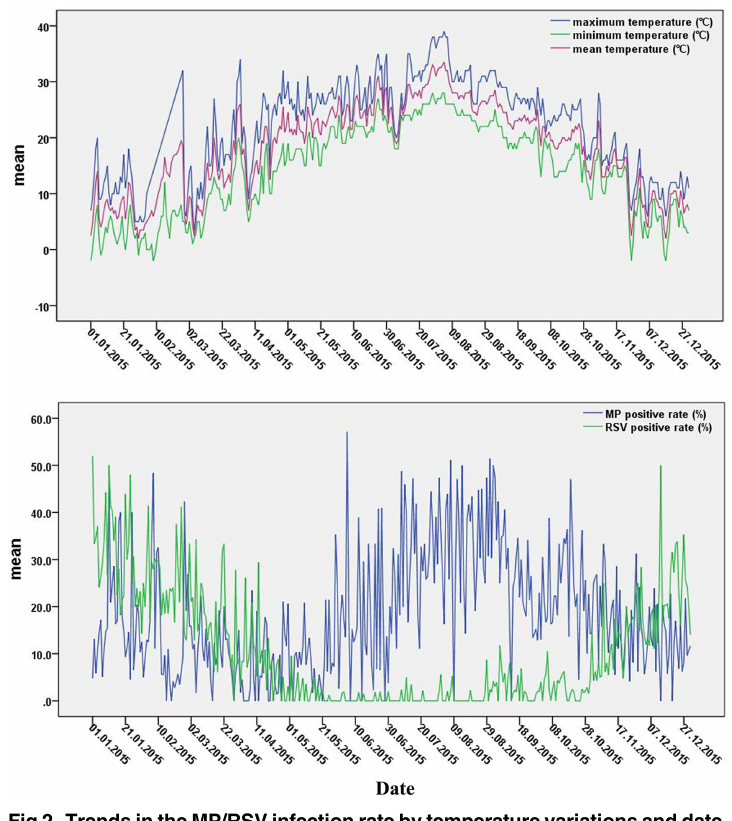
Fig 2. Trends in the MP/RSV infection rate by temperature variations and